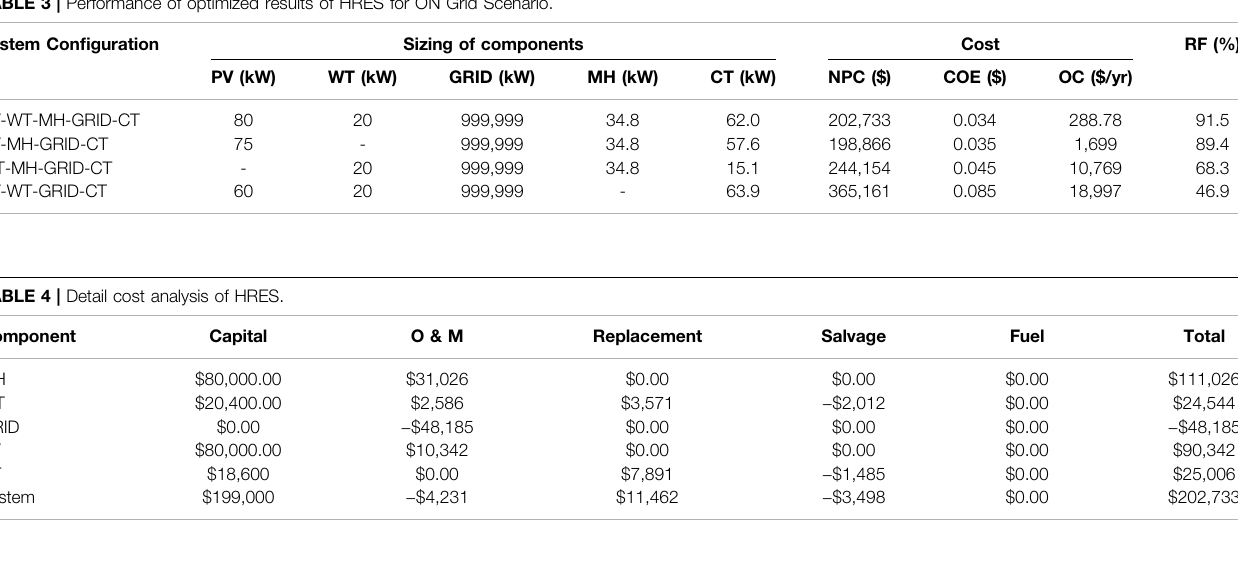
TABLE 5 | Energy generation of the optimal HRES.